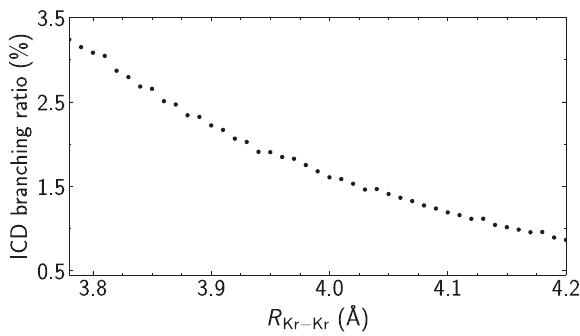
Fig. 4 Computed ICD branching ratio. ICD branching ratio as a function of the internuclear distance R of Kr atoms in a dimer scaled linearly with the number of nearest neighbors (12 atoms) for bulk atoms in an icosahedral arrangement, calculated using the Fano-ADC(2)x (extended second-order algebraic diagrammatic construction)